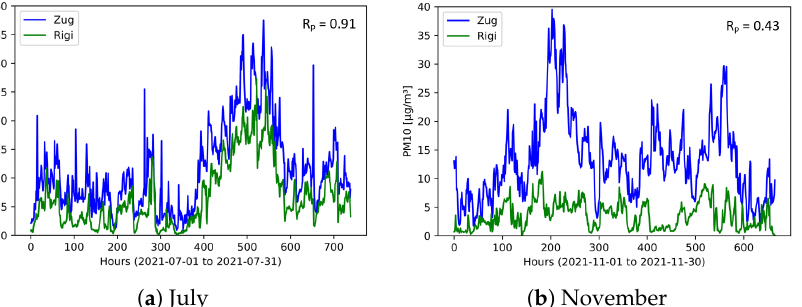
Figure 20. Hourly mean PM 10 data recorded at in-luft stations Zug and Rigi. ( a ) N = 740, R P = 0.91; ( b ) N = 665, R P = 0.43.